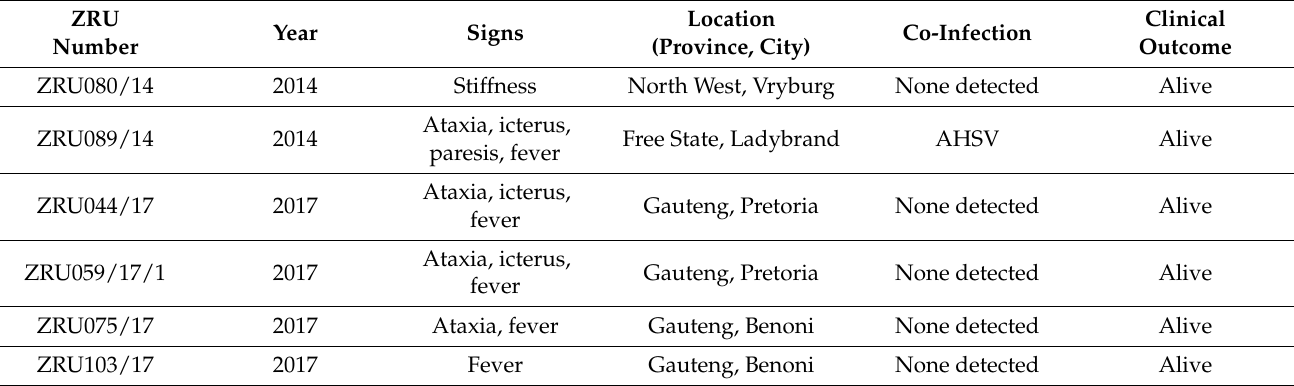
AHSV: African horse sickness virus; MIDV: Middelburg